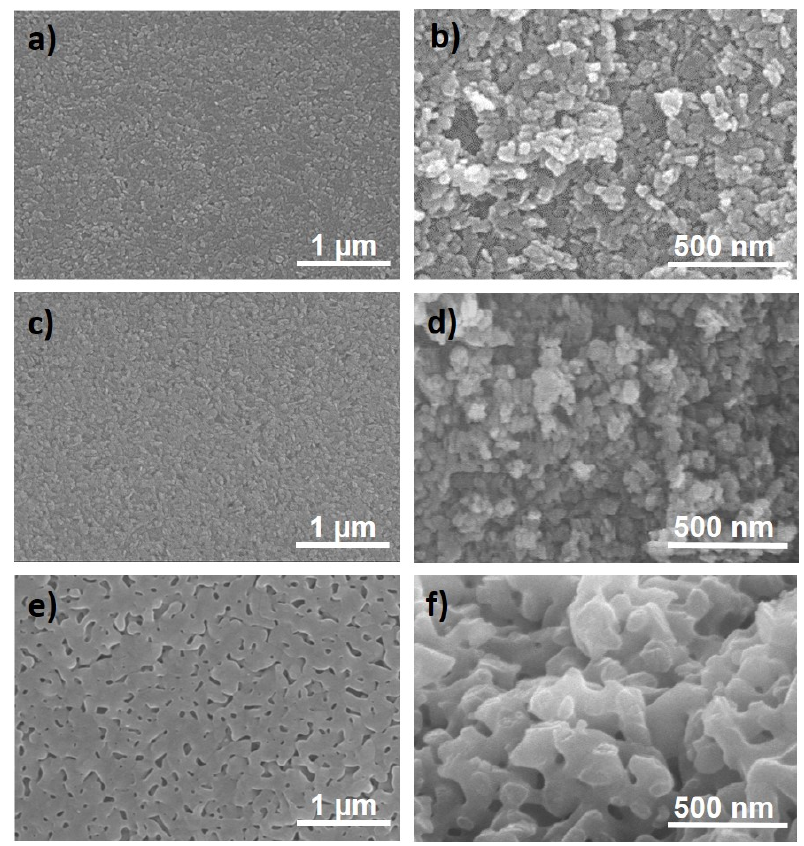
Figure 2. FESEM micrographs of rod surface ( left column ) and rod fracture surface ( right column ) in ( a , b ) bohemite, ( c , d ) γ-Al 2 O 3, and ( e , f ) α-Al 2 O 3 scaffolds.